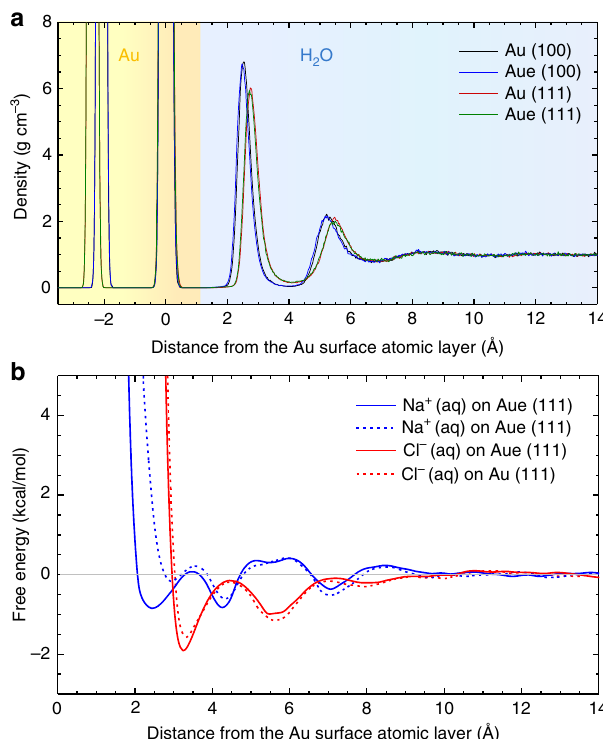
Fig. 5 Density pro fi le of water and free energy pro fi les of dissolved ions on the gold surface. a Computed density pro fi le of water on the Au (111) and Au (100) surfaces with and without polarization. The difference between the polarizable and the nonpolarizable model is barely visible. Two distinct and two further weak surface layers of water are seen on both surfaces. Water molecules approach the top layer of the metal surface atoms 0.25 Å more closely on the (100) surface than on the (111) surface. b Computed free energy pro fi le of sodium and chloride ions on the Au (111) surface in water with and without polarization. Polarization signi fi cantly changes preferred distances and adsorption energies of the ions, which is particularly visible for sodium ions at ~2.5 Å distance. Chloride ions exhibit different preferred distances compared to sodium ions and are more strongly attracted, enhanced at ~3.3 Å distance due to polarization. Adsorption energies are on the order of van-der-Waals contacts and weak hydrogen bonds. The zero point of the z coordinate corresponds to the position of the top layer of gold surface atoms in ( a ) and ( b